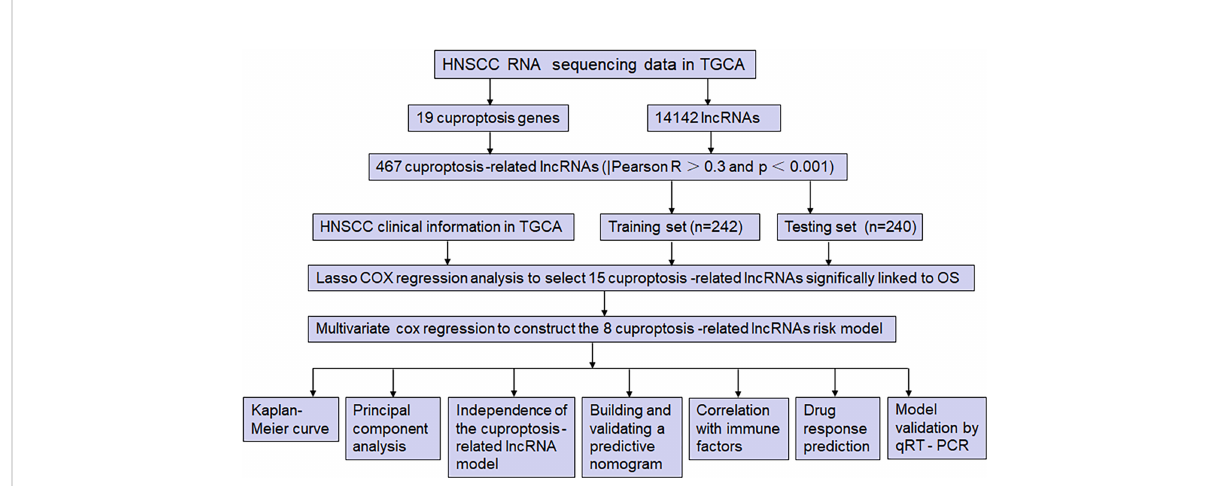
FIGURE 1 The study fl ow diagram. The TCGA database was used to obtain 19 cuproptosis-related genes matrix expression data and 14,142 lncRNAs data, and visualization of cuproptosis-related lncRNAs coexpression network is presented in Sankey diagram. In total, 467 lncRNAs underwent screening as cuproptosis-associated lncRNAs, and univariate Cox regression analysis disclosed that 32 cuproptosis-related lncRNAs in the training set and OS were signi fi cantly correlated. Then, LASSO regression was employed to detect 15 cuproptosis-related lncRNAs for multivariate analysis. Finally, eight cuproptosis-related prognostic lncRNAs (AC024075.3, AC090587.2, AC116914.2, AL450384.2, CDKN2A-DT, FAM27E3, JPX, and LNC01089) were identi fi ed as cuproptosis-related lncRNAs. Cuproptosis-related lncRNAs were analyzed by Pearson correlation method, with the LASSO and univariate/multivariate Cox analyses performed to establish the cuproptosis-related lncRNA predictive model. Subsequently, the time-dependent ROC and Kaplan-Meier analysis were applied to assess its prediction ability, and the model was veri fi ed by a nomogram, univariate/multivariate Cox analysis, and calibration curves. Furthermore, the PCA, immune analysis, and GSEA were performed, and the IC50 prediction in the risk groups was calculated. Furthermore, the expression of six cuproptosis-related lncRNAs in HNSCC and paracancerous tissues was detected by